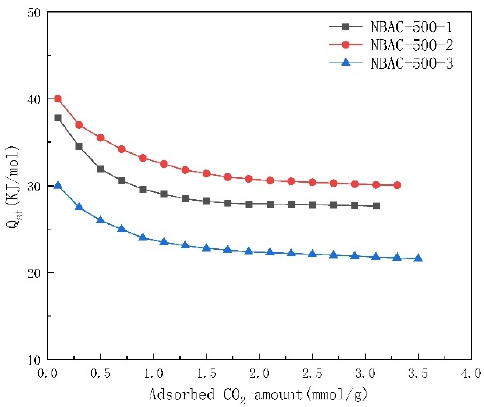
Figure 6. Isosteric heat of adsorption for NBACs synthesized at 500 °C.